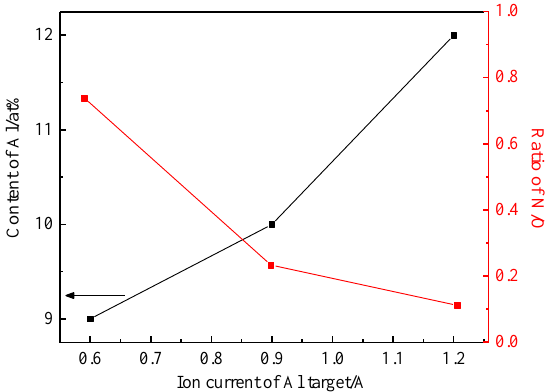
Figure 4. Effect of target current on Al content and the ratio of N/O.